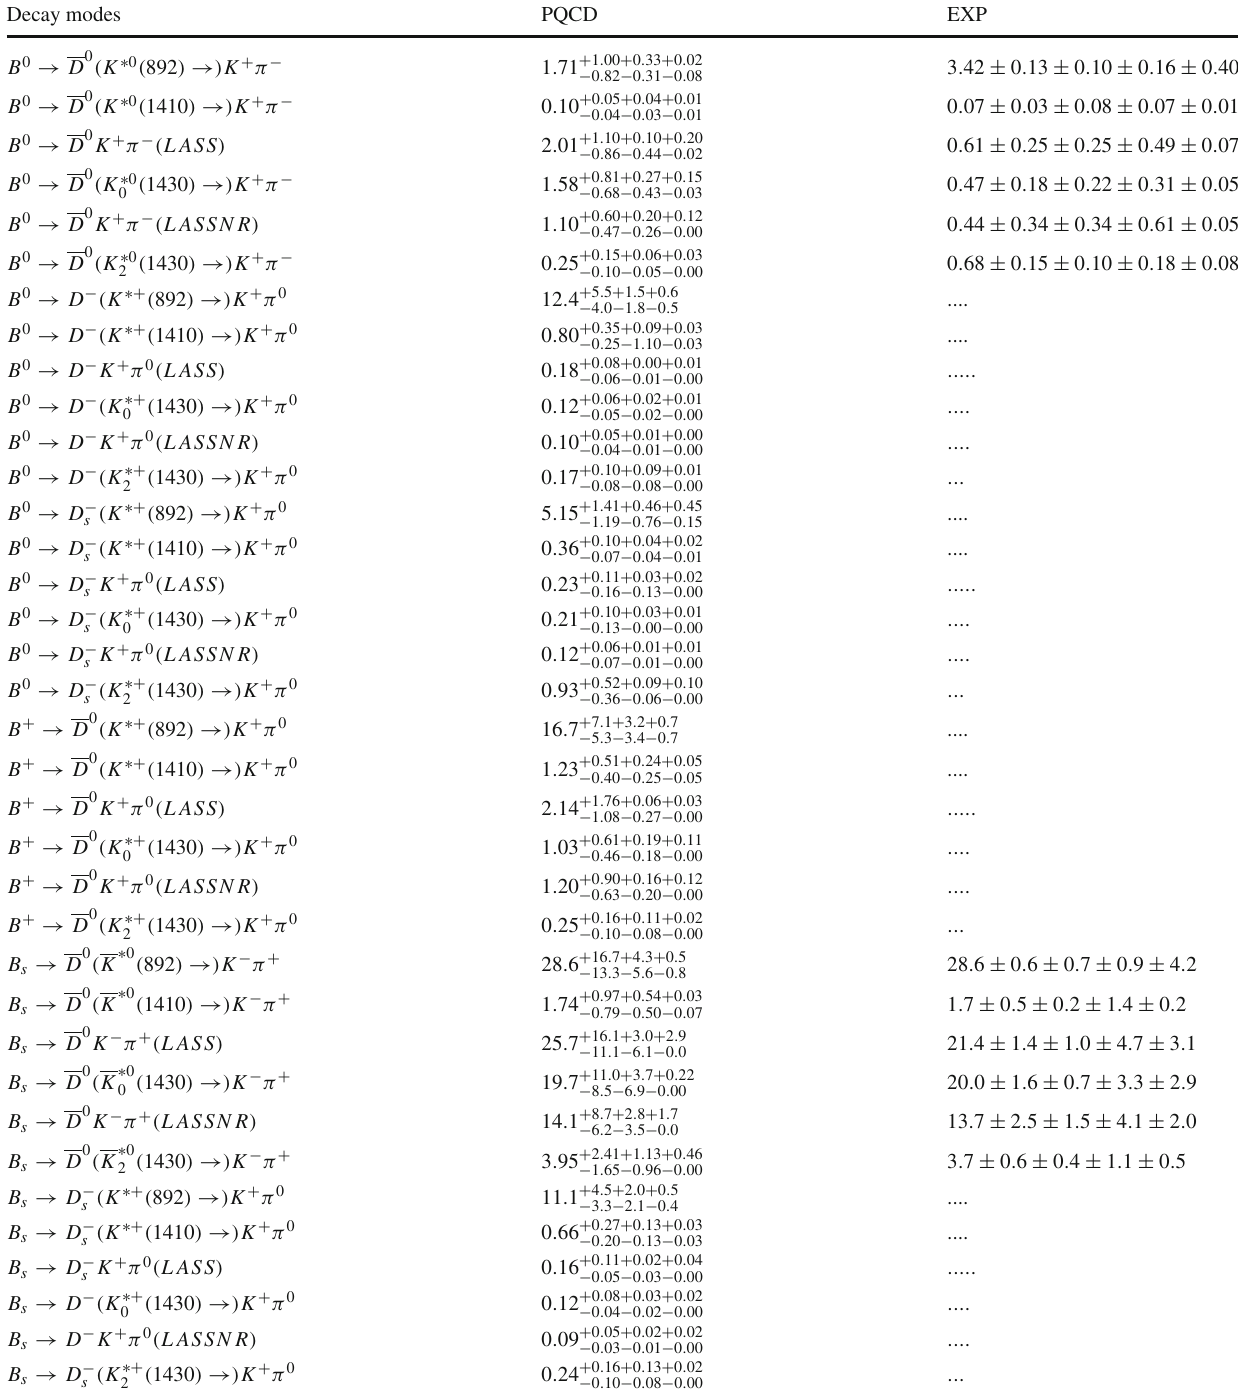
Table 1 The flavour-averaged branching ratios (in 10 − 5 ) of B ( s ) → DK π decays with resonances K ∗ ( 892 )/( 1410 ) , K ∗ PQCD approach, together with the experimental data [45,46] from LHCb Decay modes